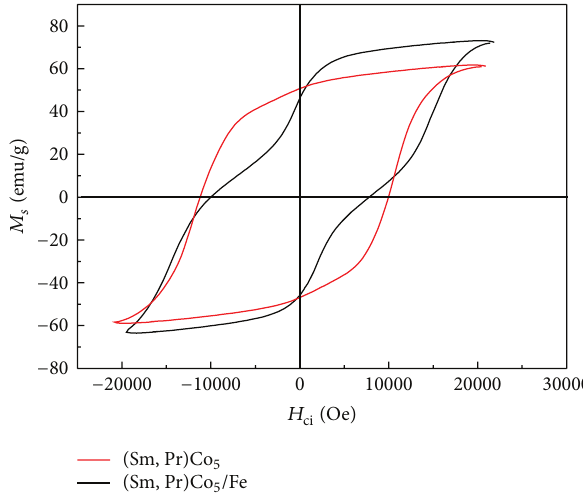
Figure 4: Magnetic hysteresis loops of aligned (Sm,Pr)Co 5 nanoflakes and (Sm,Pr)Co 5 /Fe